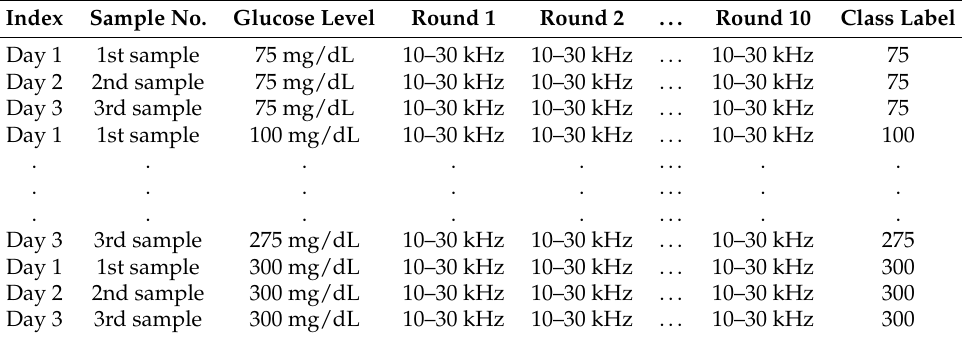
Table 4. Summary of the measurement procedures for glucose